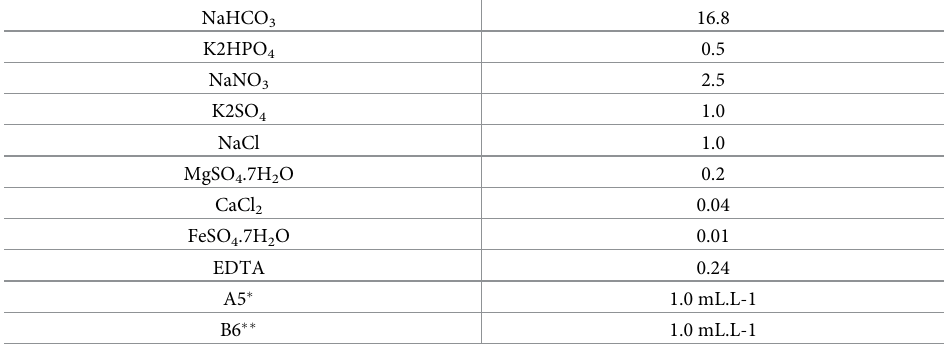
Table 1. Composition of the Zarrouk Component Quantity medium (g.L -1 ) (Zarrouk